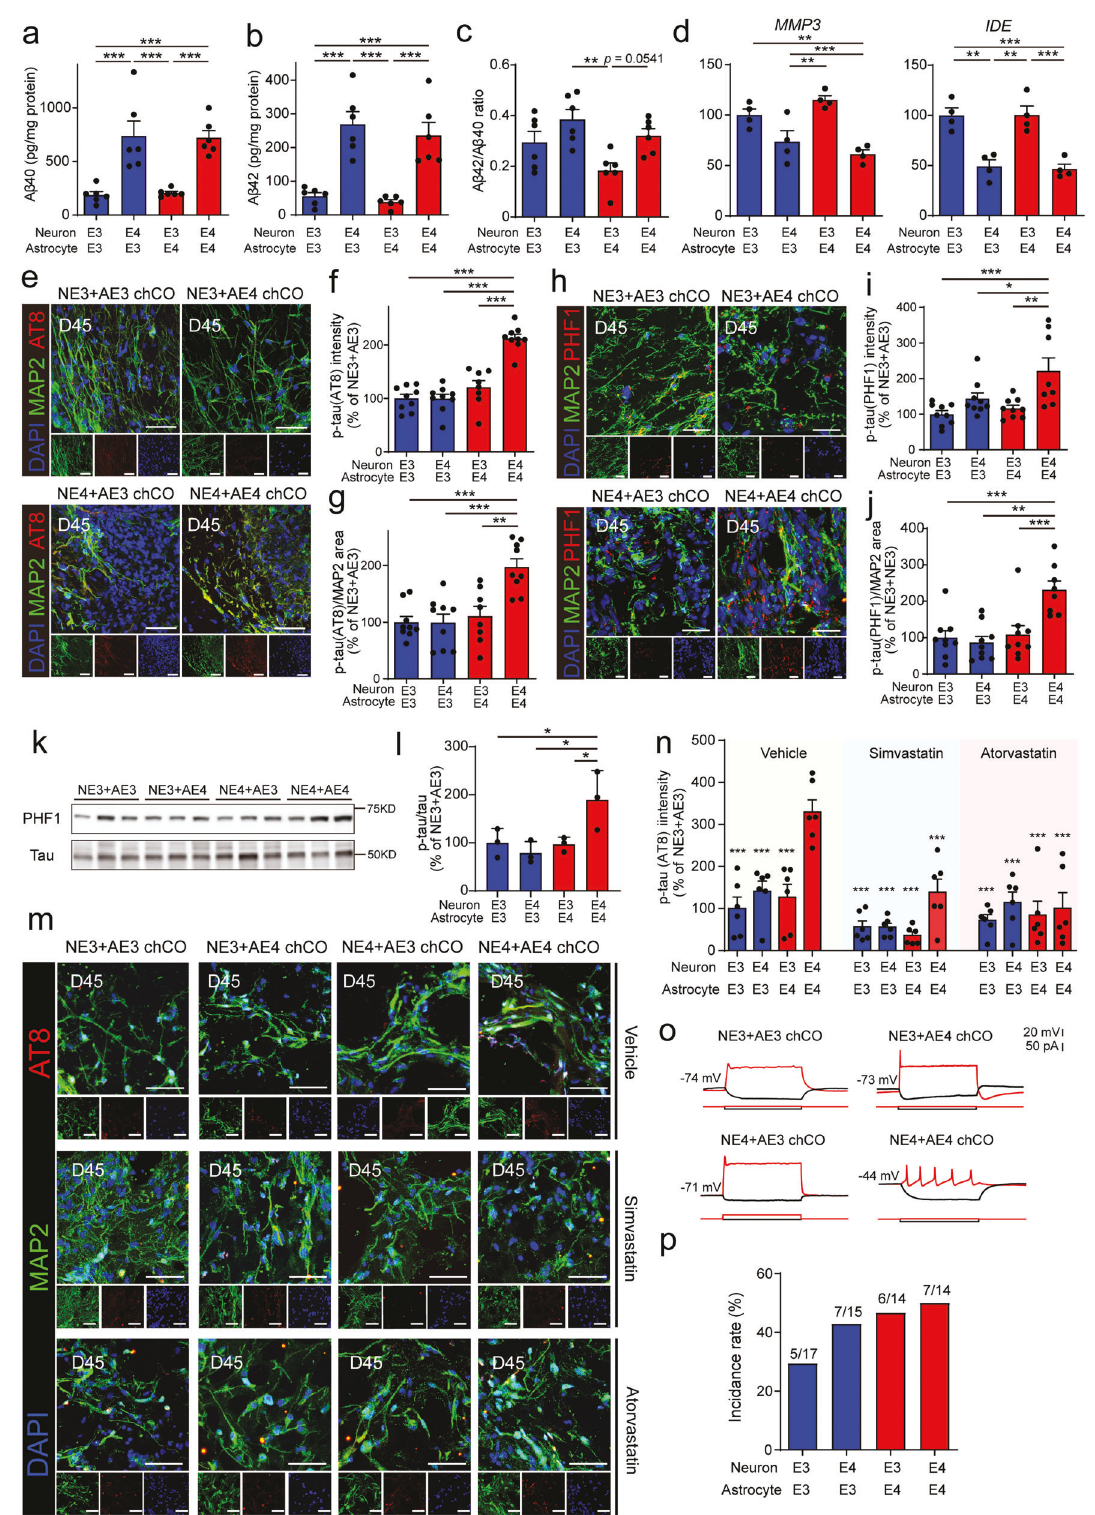
with 0.05 mg/ml fi lipin (MCE, HY-N6716) in PBS containing 10% FBS for 2 h and rinsed three times with PBS. For lipid droplet staining, sections were washed three times with PBS and stained with LipidTox (Thermo Fisher Scienti fi c, H34477) according to the manufacturer ’ s protocols. EdU staining were performed with Signal Transduction and Targeted Therapy (2022)